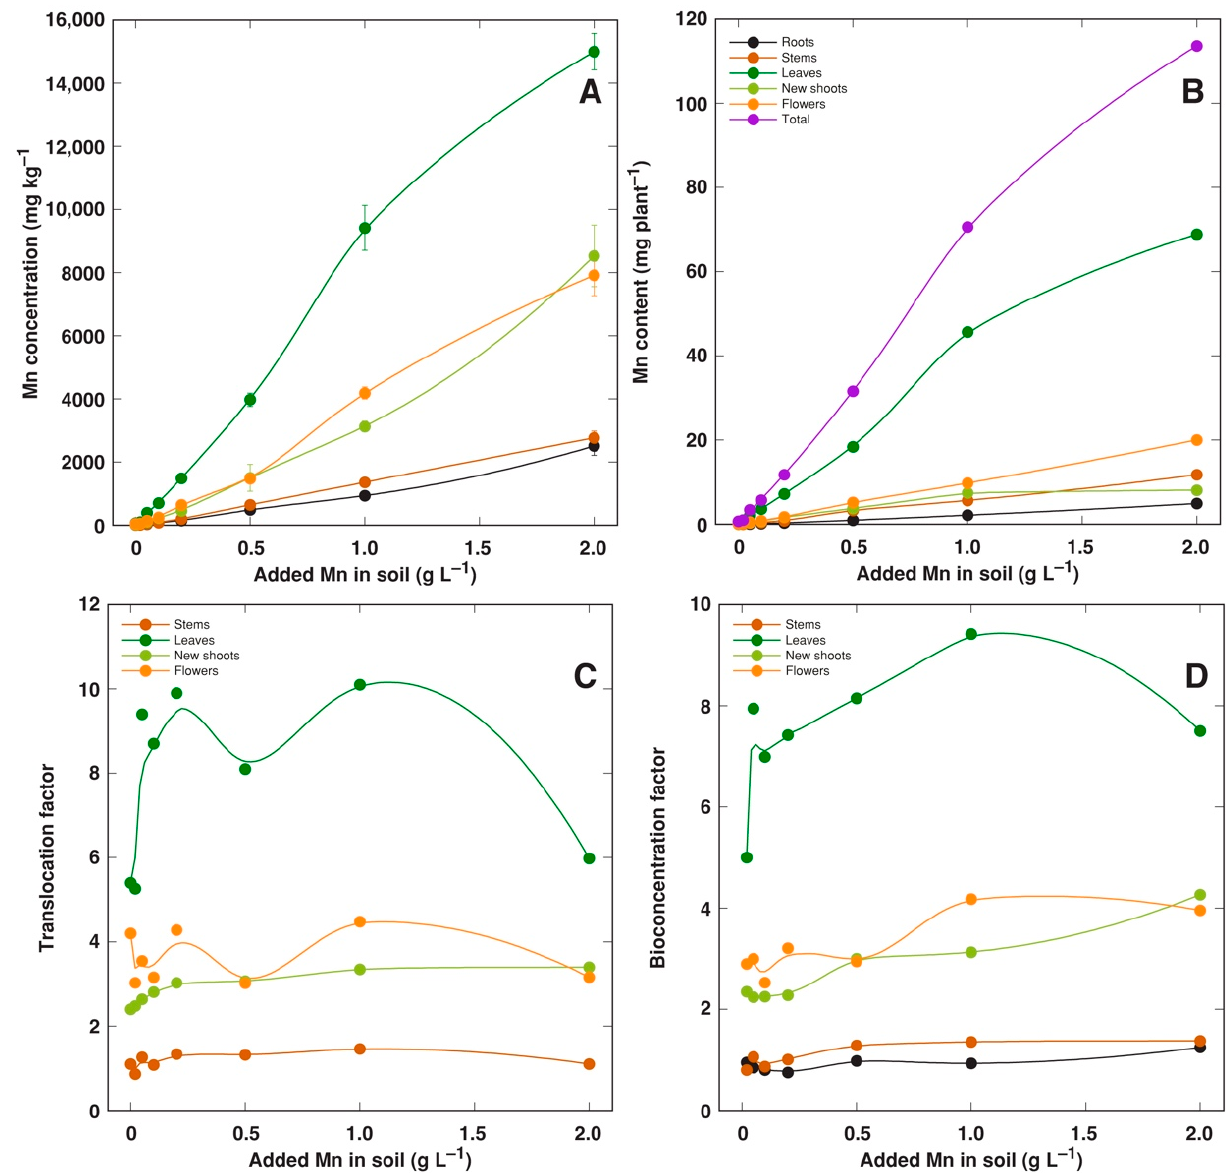
Figure 10. Effect of treatment with different concentrations of Mn on Mn concentration ( A ), Mn content ( B ), translocation factor for Mn ( C ), and bioconcentration factor for Mn ( D ) in different parts of H. maximum plants (Experiment 2). Data are means ± SE from 3 replicates for each point.